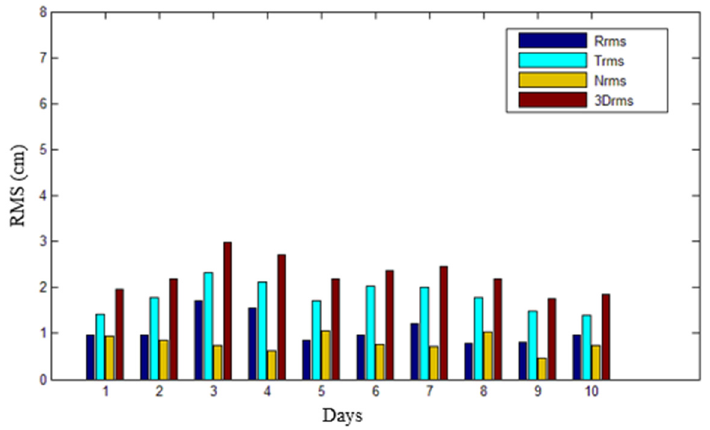
Figure 3. QQ-Satellite statistics of the accurate analysis of the precise orbit determination. Rrms, Trms and Nrms indicate the root mean squared (RMS) errors in the radial–transverse–normal (RTN) directions, respectively.